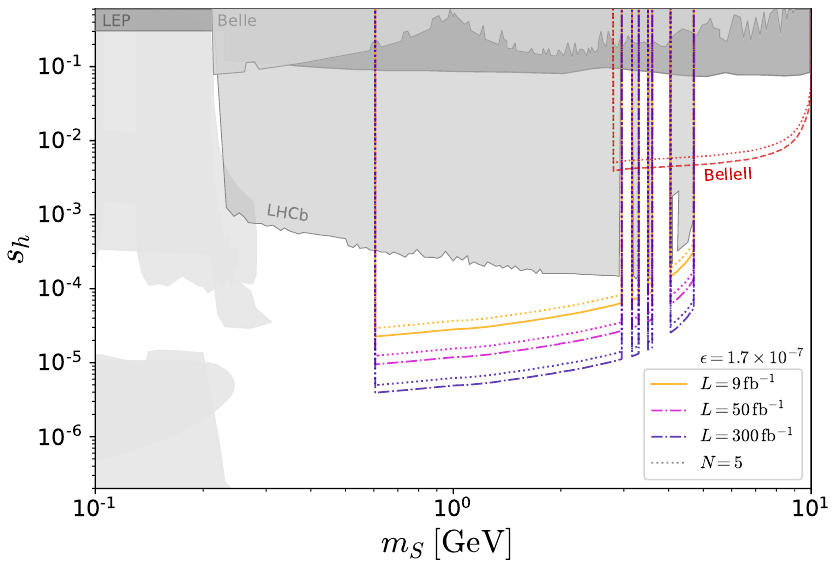
Figure 9 . Projected sensitivities on the dark Higgs parameter space for the LHCb (solid) and Belle II (dashed) searches considering the current LHCb integrated luminosity (orange), and the future reach perspectives of L = 50 fb − 1 (pink) in Run 3–4 and L = 300 fb − 1 (purple) in Run 5–6 [59]. The dotted lines are the corresponding N = 5 events curves that represent the discovery